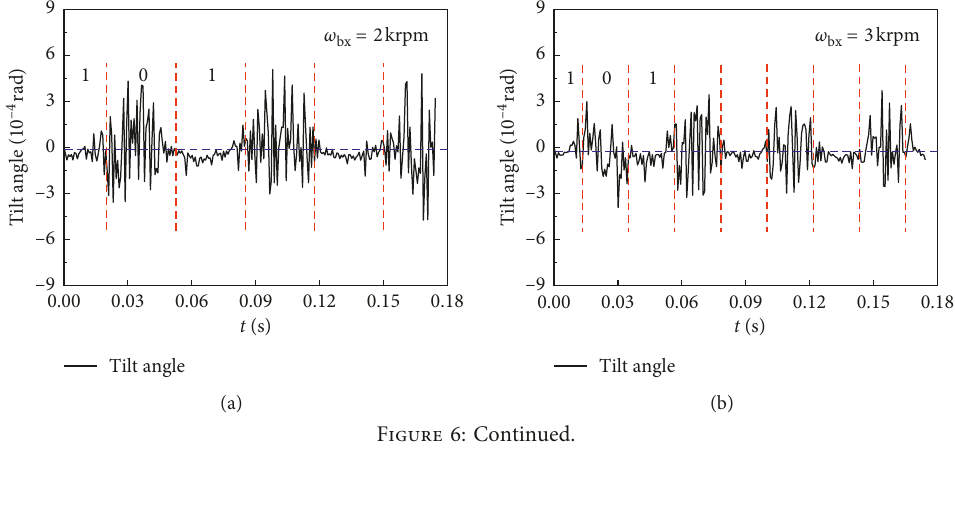
� 20kN; F � 0; ω � r a bx